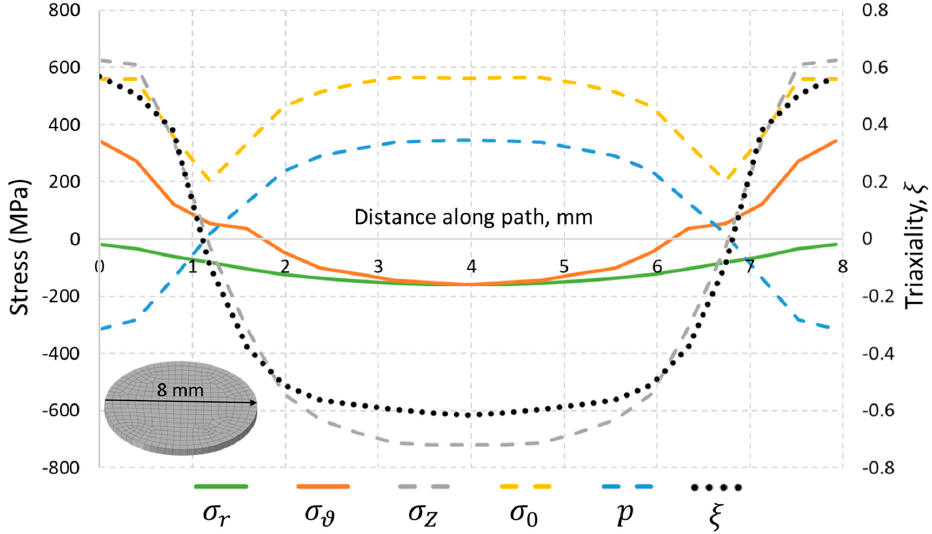
Figure 11. Stress characteristics along the diametral path.